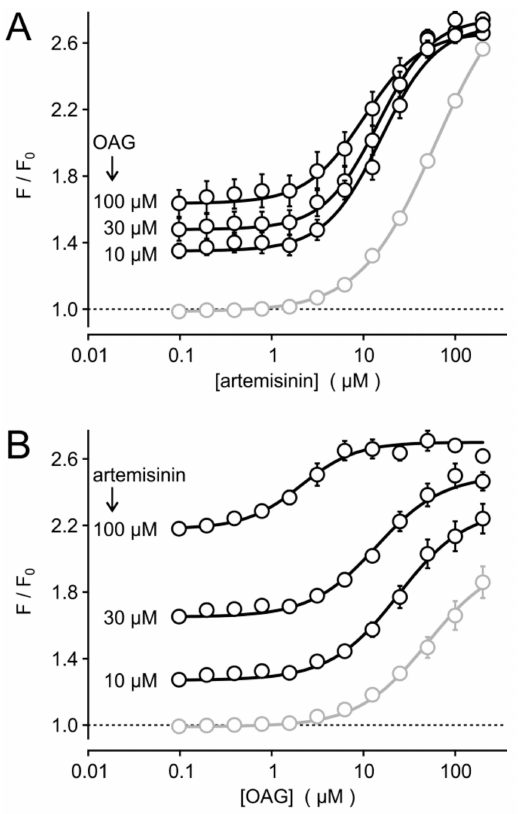
Figure3. E ff ectsofacuteco-stimulationofHEK TRPC3-YFP cellswithvariousconcentrationsofartemisinin and OAG. Fluo 4-loaded HEK TRPC3-YFP cell suspensions were assayed in a fluorescence imaging plate reader during acute co-application of serially diluted artemisinin without (grey symbols and lines) or with OAG added at the indicated fixed concentrations ( A ). ( B ) Similar experiment as in ( A ), but with serially diluted OAG in the absence or presence of the indicated fixed artemisinin